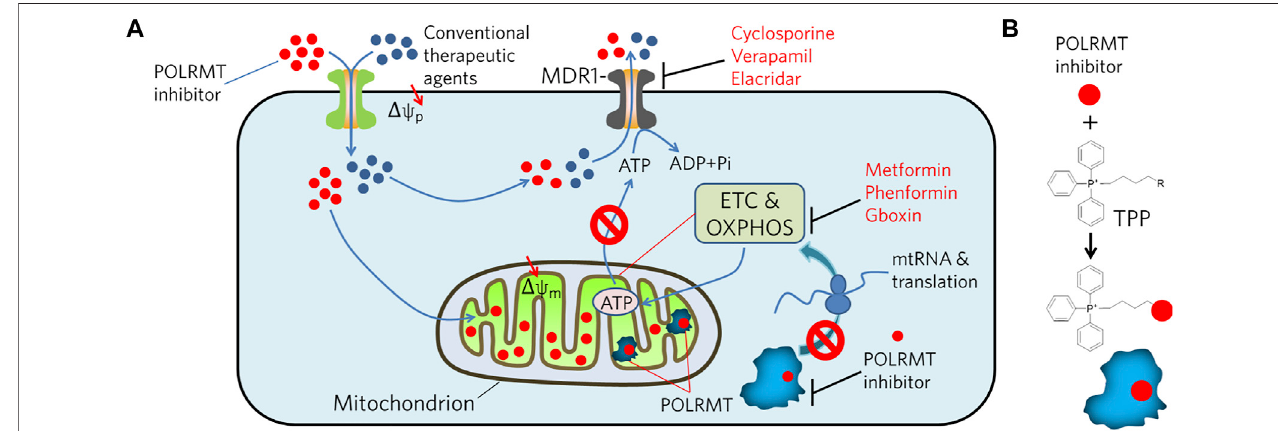
FIGURE 2 | Illustration of potential strategies to combat MDR tumors by inhibiting POLRMT in concert with MDR1. (A) MDR1 ef fl uxes chemicals, i.e. POLRMT inhibitors and conventional therapeutic agents, from the cytosol out of the cell in an ATP-dependent manner. However, inhibition of POLRMT blocks its mediated transcription of mtDNA, thereby inhibiting translation of the ETC and OXPHOS complexes. As a result, ATP production is compromised and ultimately leads to the inhibition of ATP-dependent chemical ef fl ux by MDR1. (B) Conjugation of POLRMT inhibitors to lipophilic TPP is designed to facilitate its permeation to the plasma and mitochondrial membranes driven by the membrane potential ( Δ ψ ) and accumulates several hundred-fold in the mitochondrial